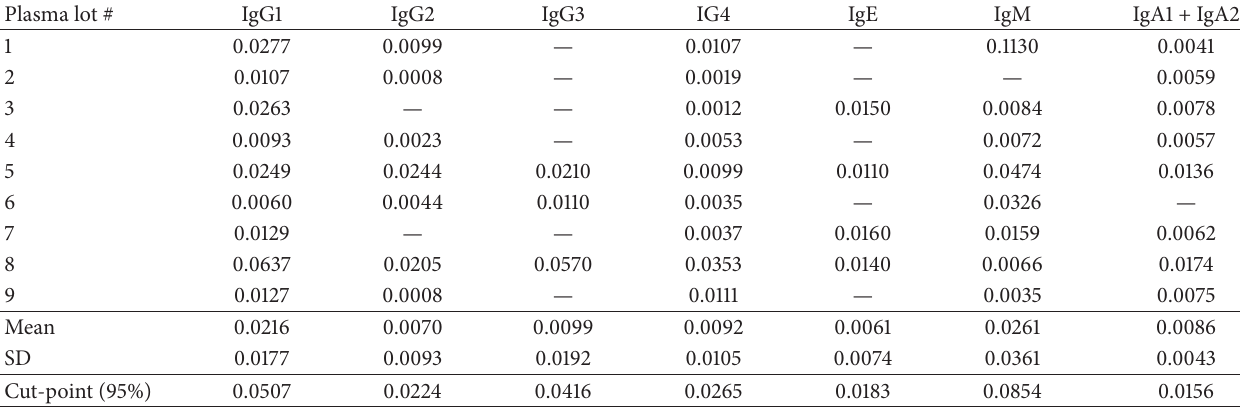
Table 2: LC/MS peak area ratio response and cut-points of ADA isotopes/subclasses in PEA negative human plasma with drug as ADA capture reagent.